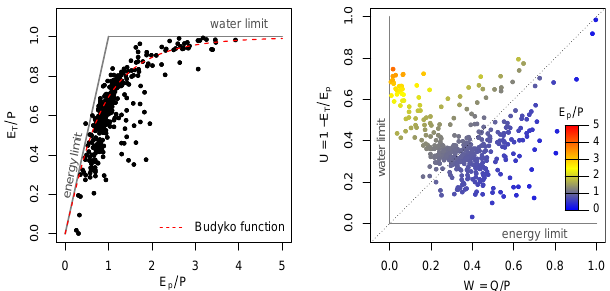
Fig. 2. Budyko (left) and UW space (right) plots of the period (1949–2003) of the MOPEX dataset. E p is obtained from the CRU TS 3.1 E p product. The 1 : 1 line in the UW space diagram sepa- rates areas with energy limitation ( E p /P < 1) and water limitation ( E p /P > 1). Grey lines indicate the water and energy limits.